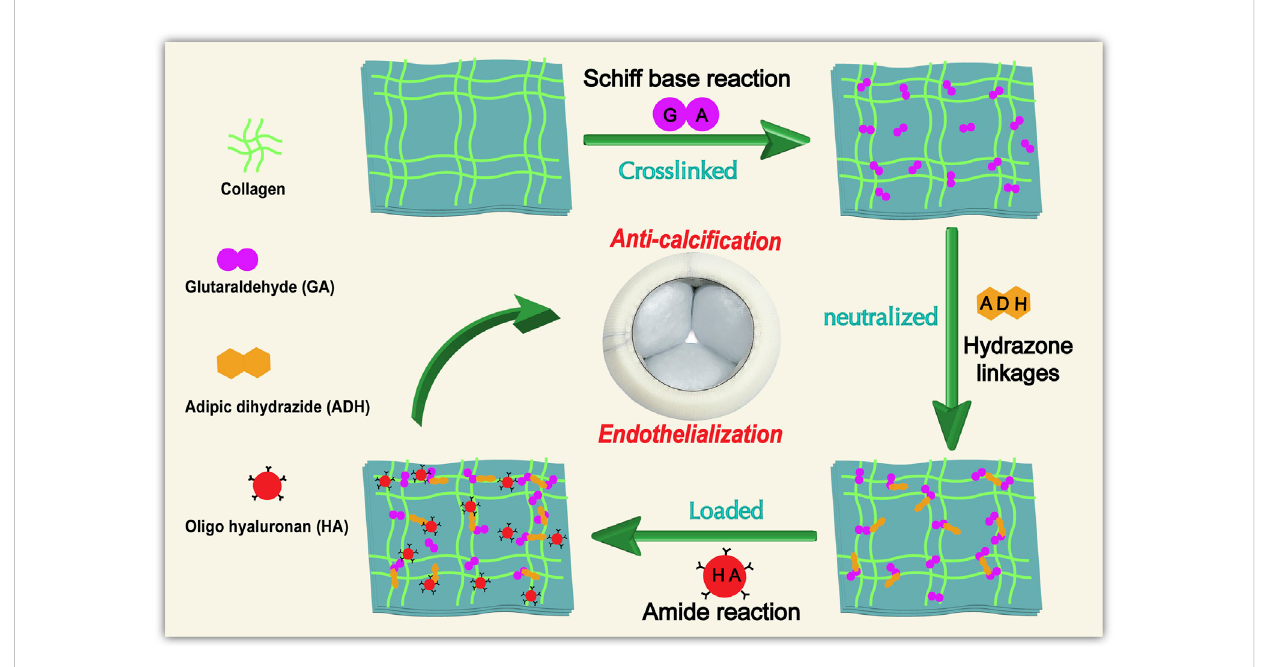
FIGURE 1 General procedure and reaction principle for the treatment of Glut-crosslinked bovine pericardium modi fi cation.